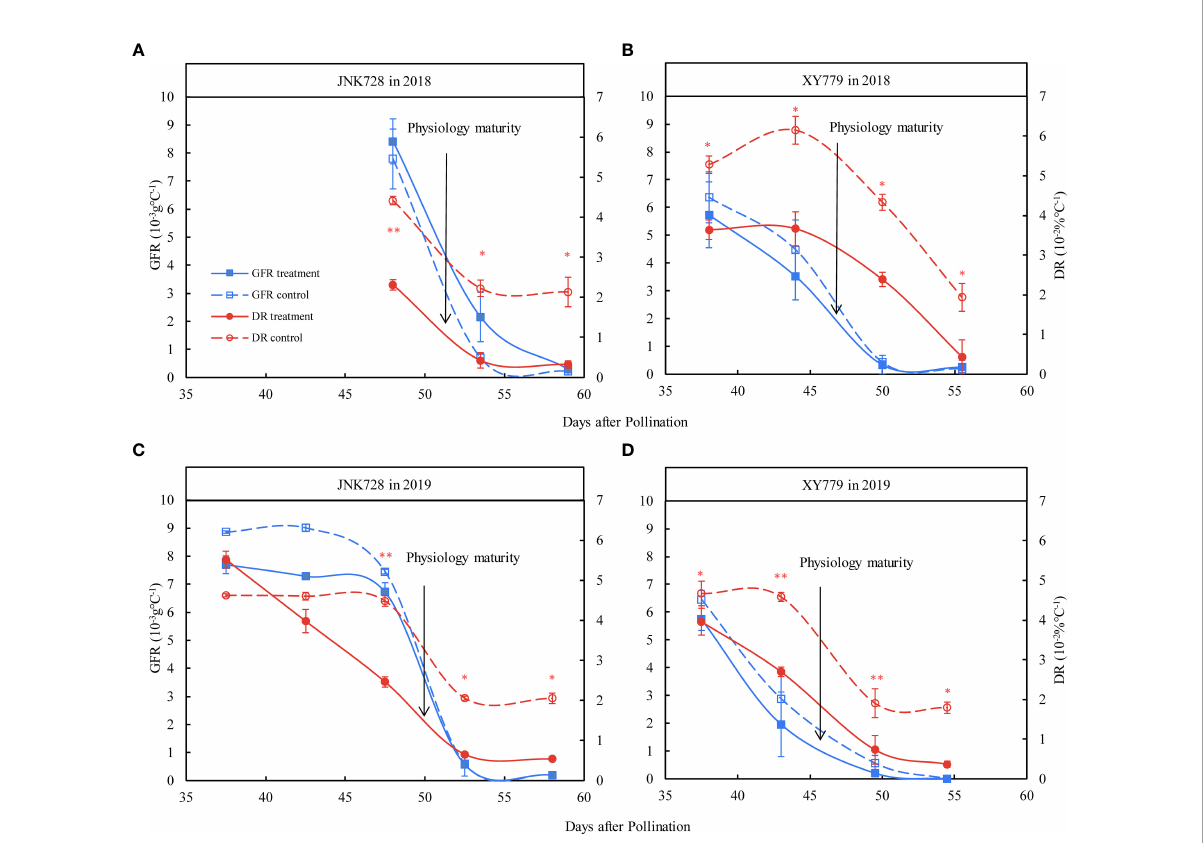
FIGURE 5 The Paired samples T-test analysis of the grain fi lling rates (GFR) and dehydration rates (DR) of the 20 grains of the treatment and control collected from (A, C) JNK728 and (B, D) XY779, each, at the late stages of grain fi lling in 2018 and 2019. The single asterisk “ * ” indicates signi fi cance at 0.05, while the double asterisk “ ** ” indicates signi fi cance at the 0.01 probability levels. The values are presented as means ± SE